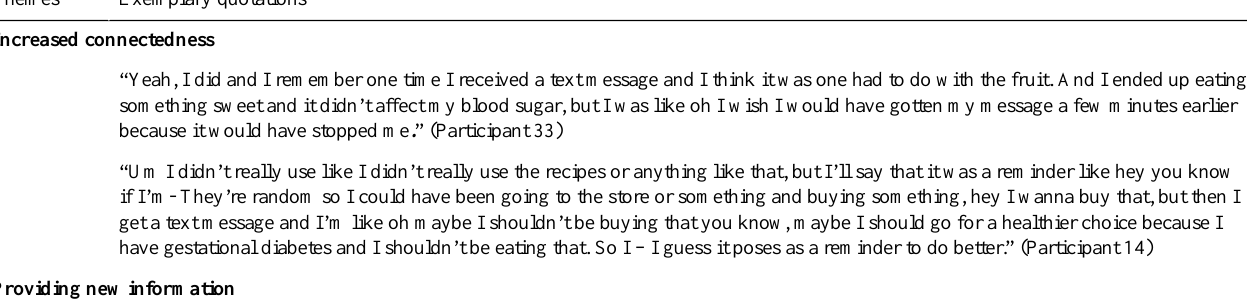
Table 3. Participant experiences of Texting for Diabetes